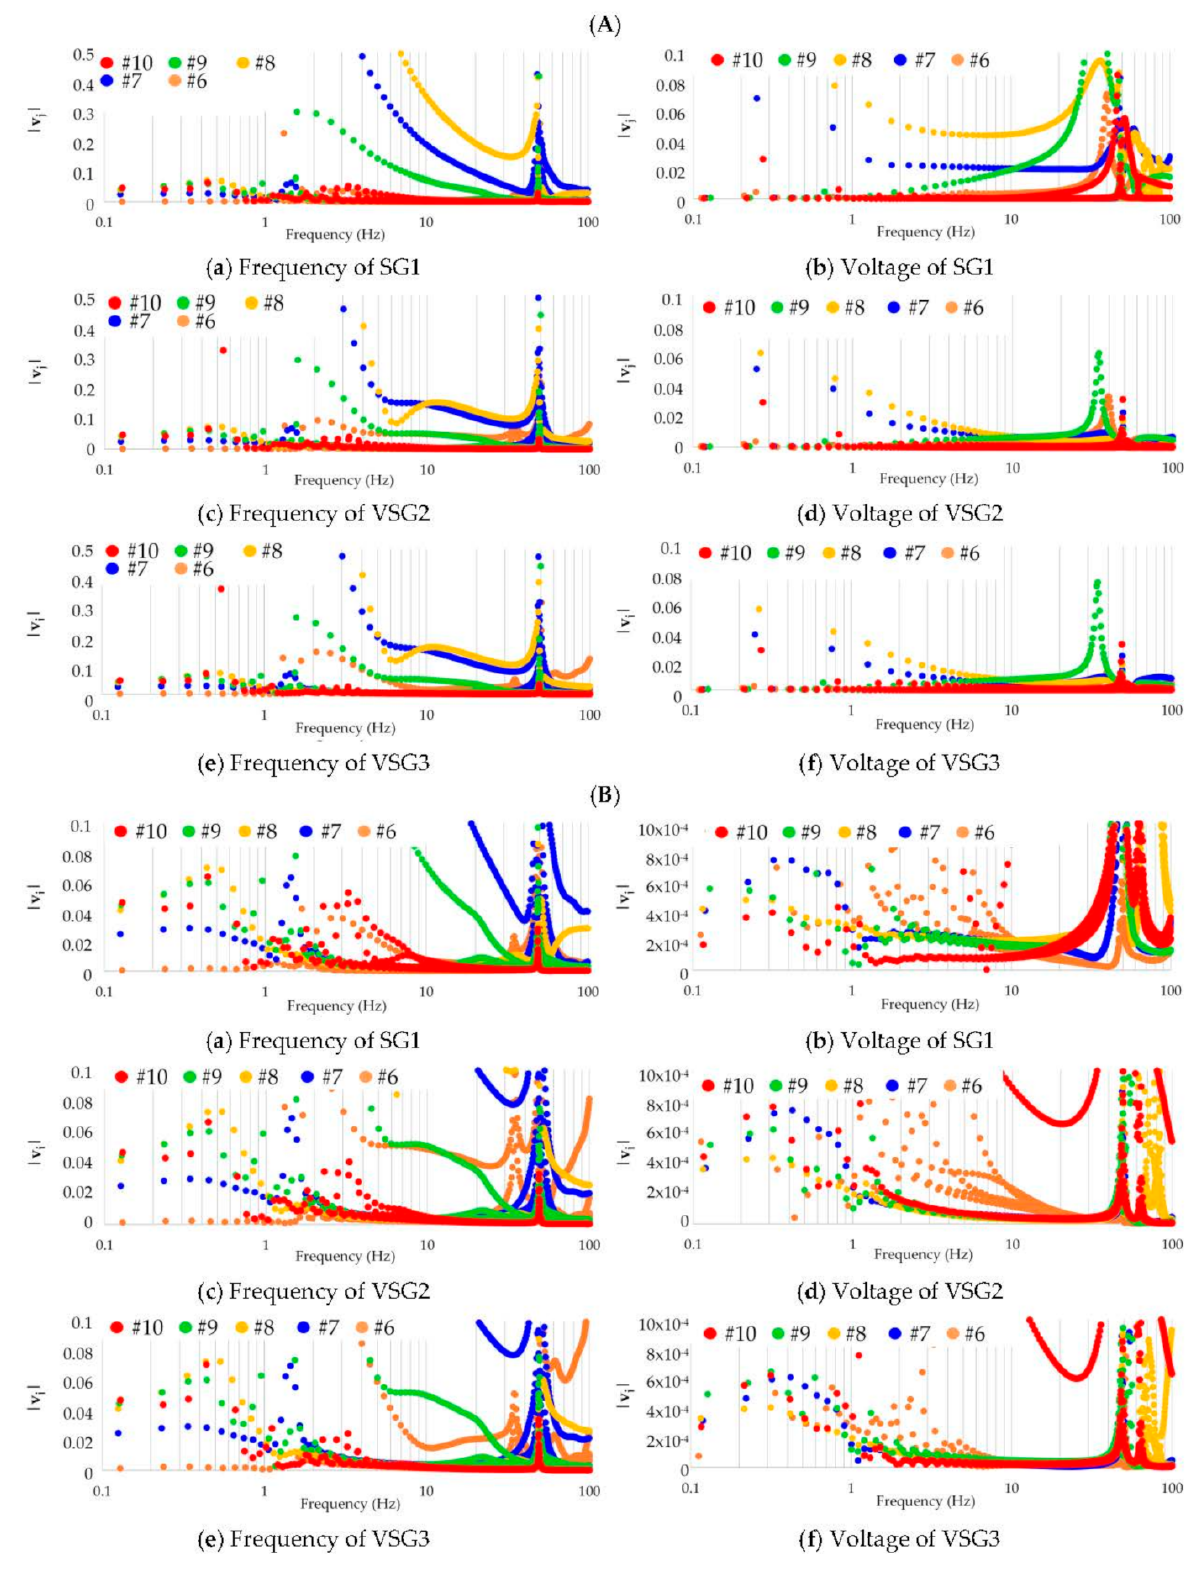
Figure 13. ( A ) Frequency response of the KMs of the system frequency/voltage for tests 6–10 in Table 1. ( B ) Frequency response of the KMs of the system frequency/voltage (enlarged | v i | ) for tests 6–10 in Table